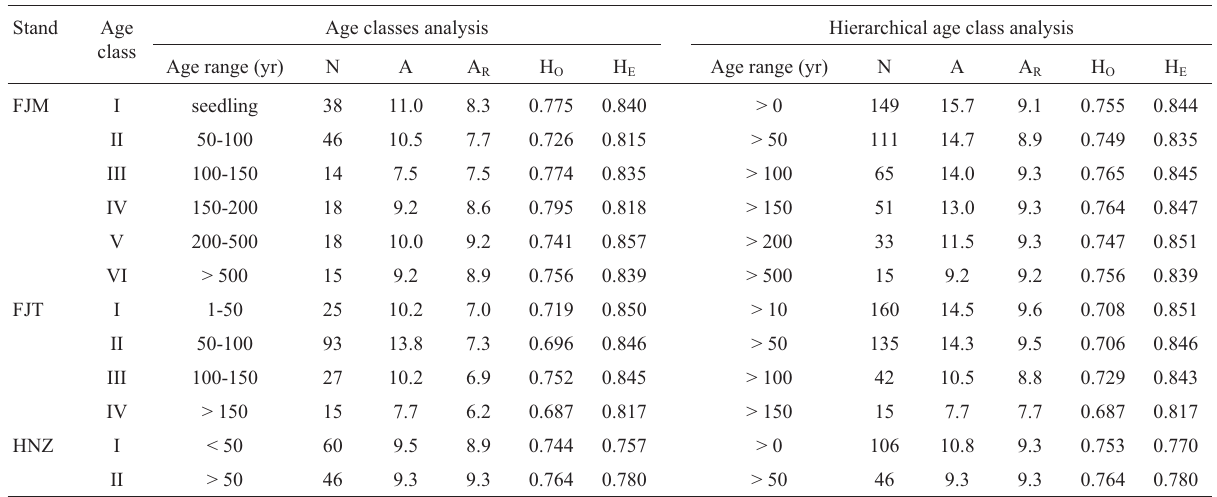
merase (Fermentas, Lithuania) for both nSSR and cpSSR. The amplification protocol was essentially similar to that